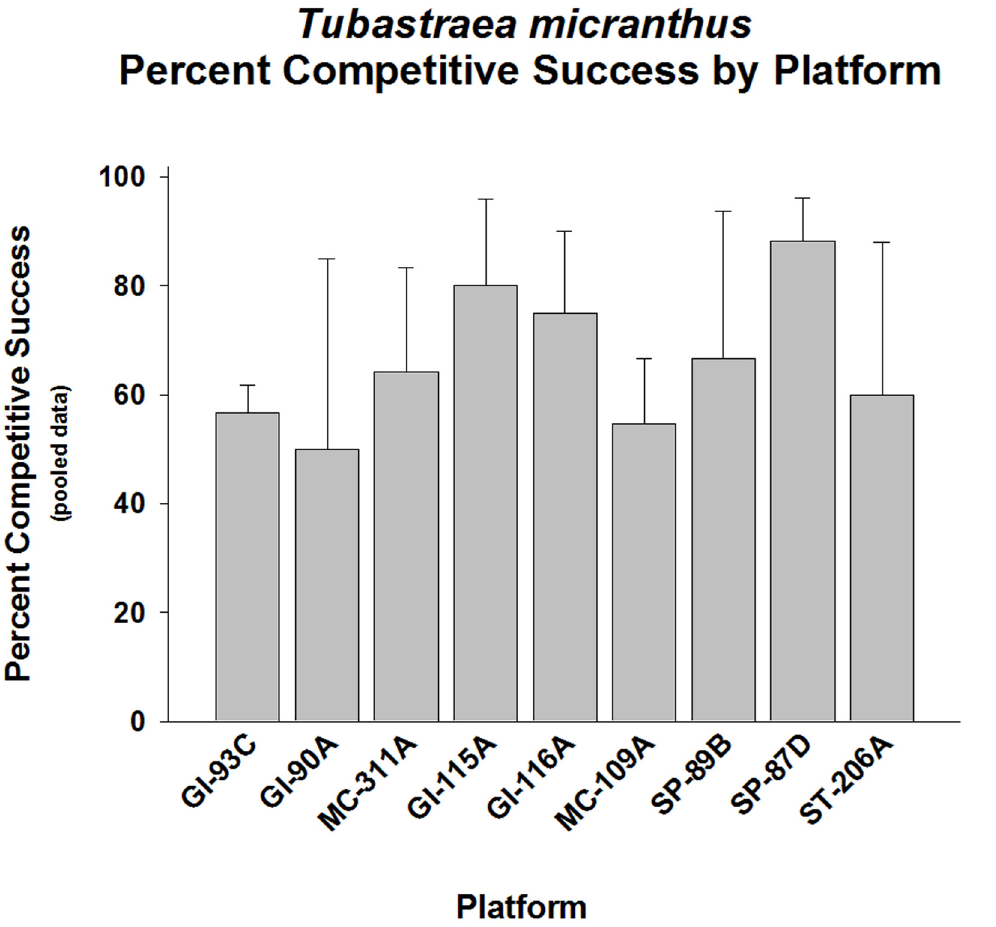
Fig 2. Percent wins in competition for space between Tubastraea micranthus and all other sessile epifauna pooled, by platform. Percent competitive success plus 95% confidence limits shown. The competition variable is defined as the number of competitive successes over the total number of interactions within a taxonomic group. An overgrowth frequency of significantly > 50% was considered to be an indicator of competitive success. A total of 15 platforms were surveyed. Those platforms possessing a number of interactions sufficient for quantitative analysis were included in the study. Data tested for significant variation from 1:1 ratio of competitive successes to losses. Range of number of interactions per platform (n): 18 – 361. Overall competitive success was significantly higher than the expected 50% level over all platforms (p < 0.01, Fisher ’ s Exact Test). Highly variable win frequencies between platforms (p < 0.001, Goodness of Fit Test, G-statistic). No significant sub-sets of platforms.